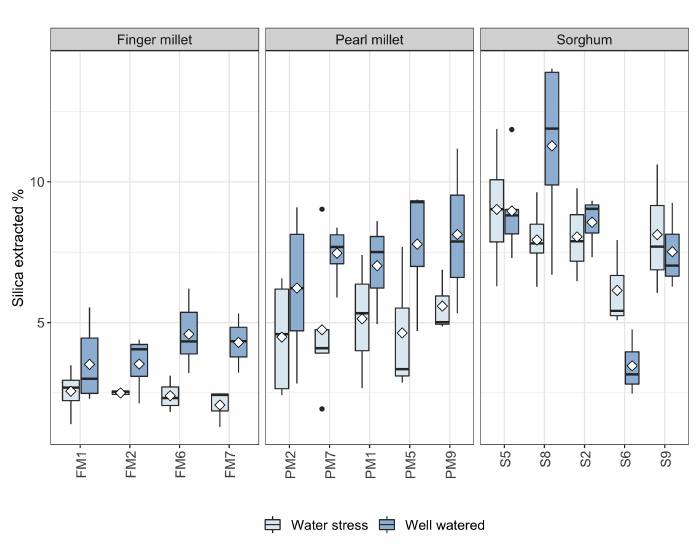
Figure 4. Boxplot of silica accumulation % values for the landraces of finger millet, pearl millet and sorghum by water treatments. Horizontal bar = median, white diamond = mean, black dots =